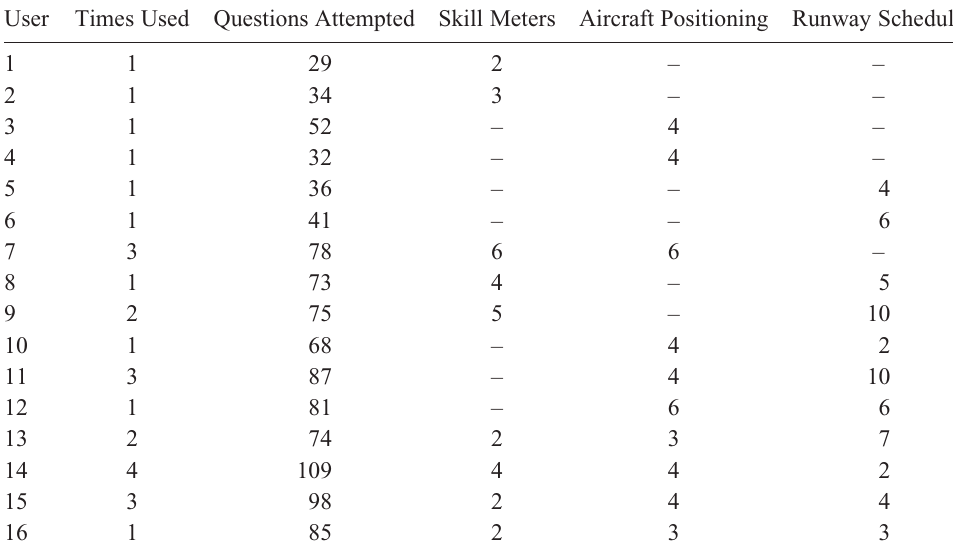
Table 1. Level of use and learner model views used. User